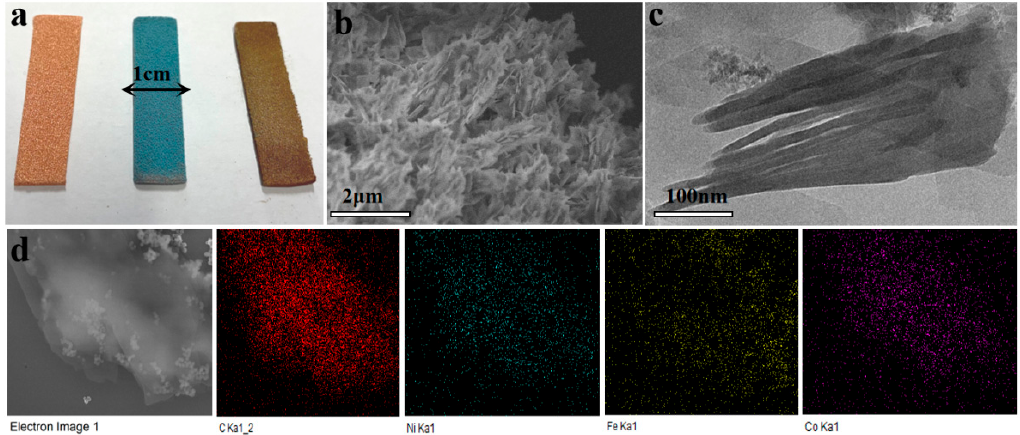
Figure 1. Morphology and composition analysis: ( a ) Digital photos of the stage reaction products, ( b ) SEM image of Cu(OH) 2 @FCN MOF/CF, ( c ) TEM image of FCN MOF nanosheets with an inset of the FFT pattern of the FCN MOF nanosheets, ( d ) SEM image and SEM elemental mapping of FCN MOF nanosheets.